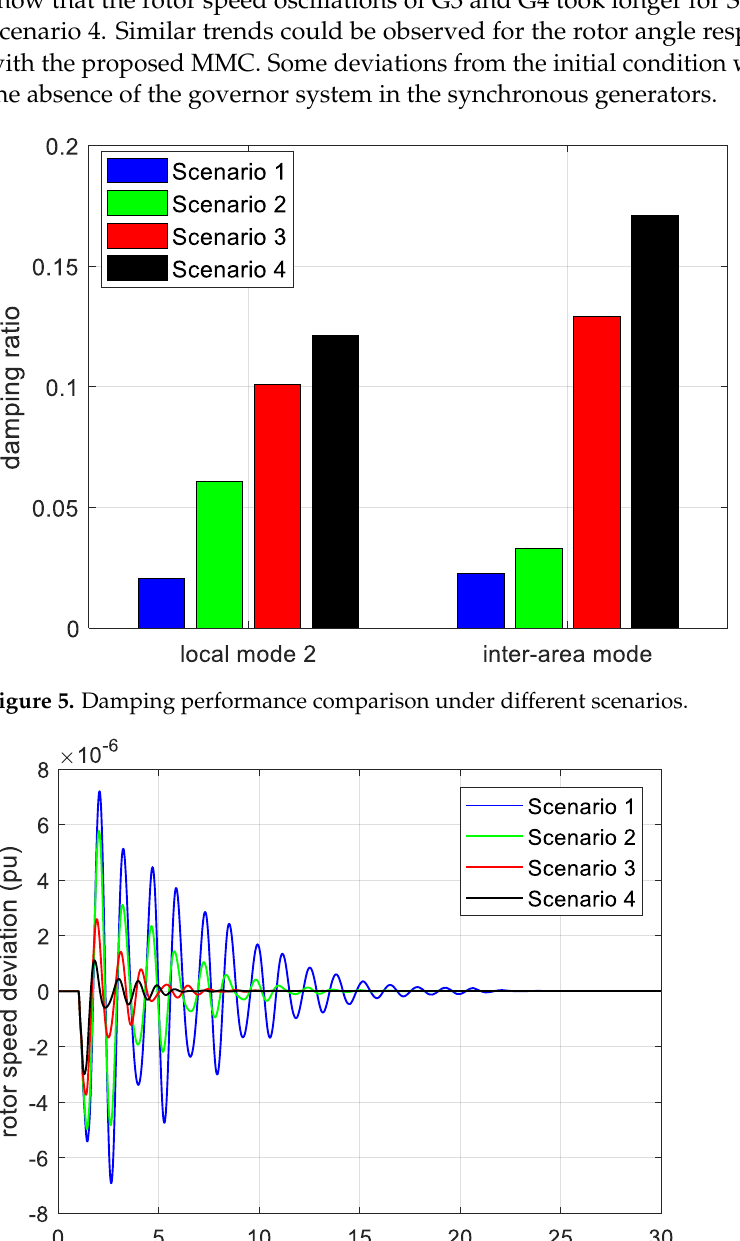
Figure 7. Rotor angle responses of G3.